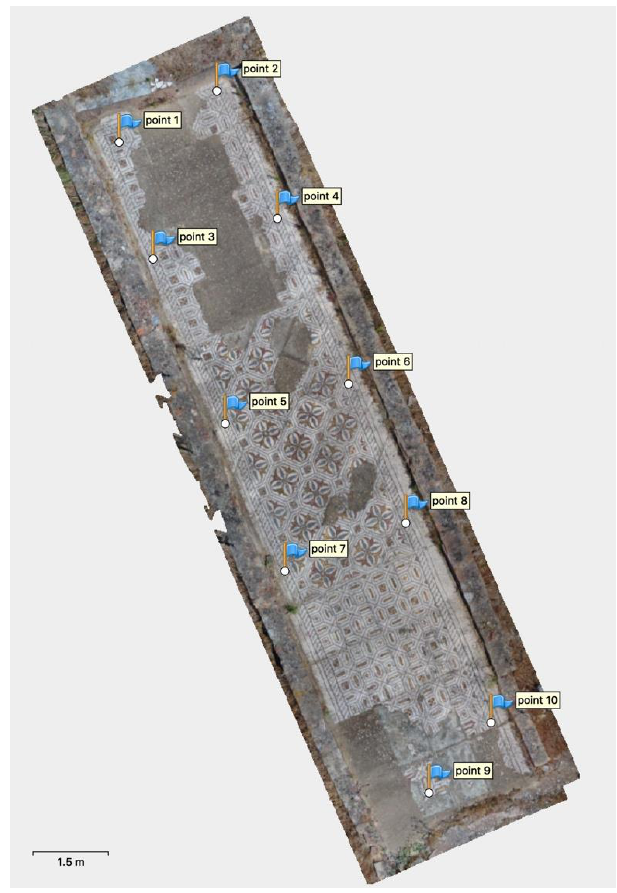
Figure 6. Position of the ten ground control points used to geometrically correct the unmanned aerial vehicle (UAV) mosaic survey.